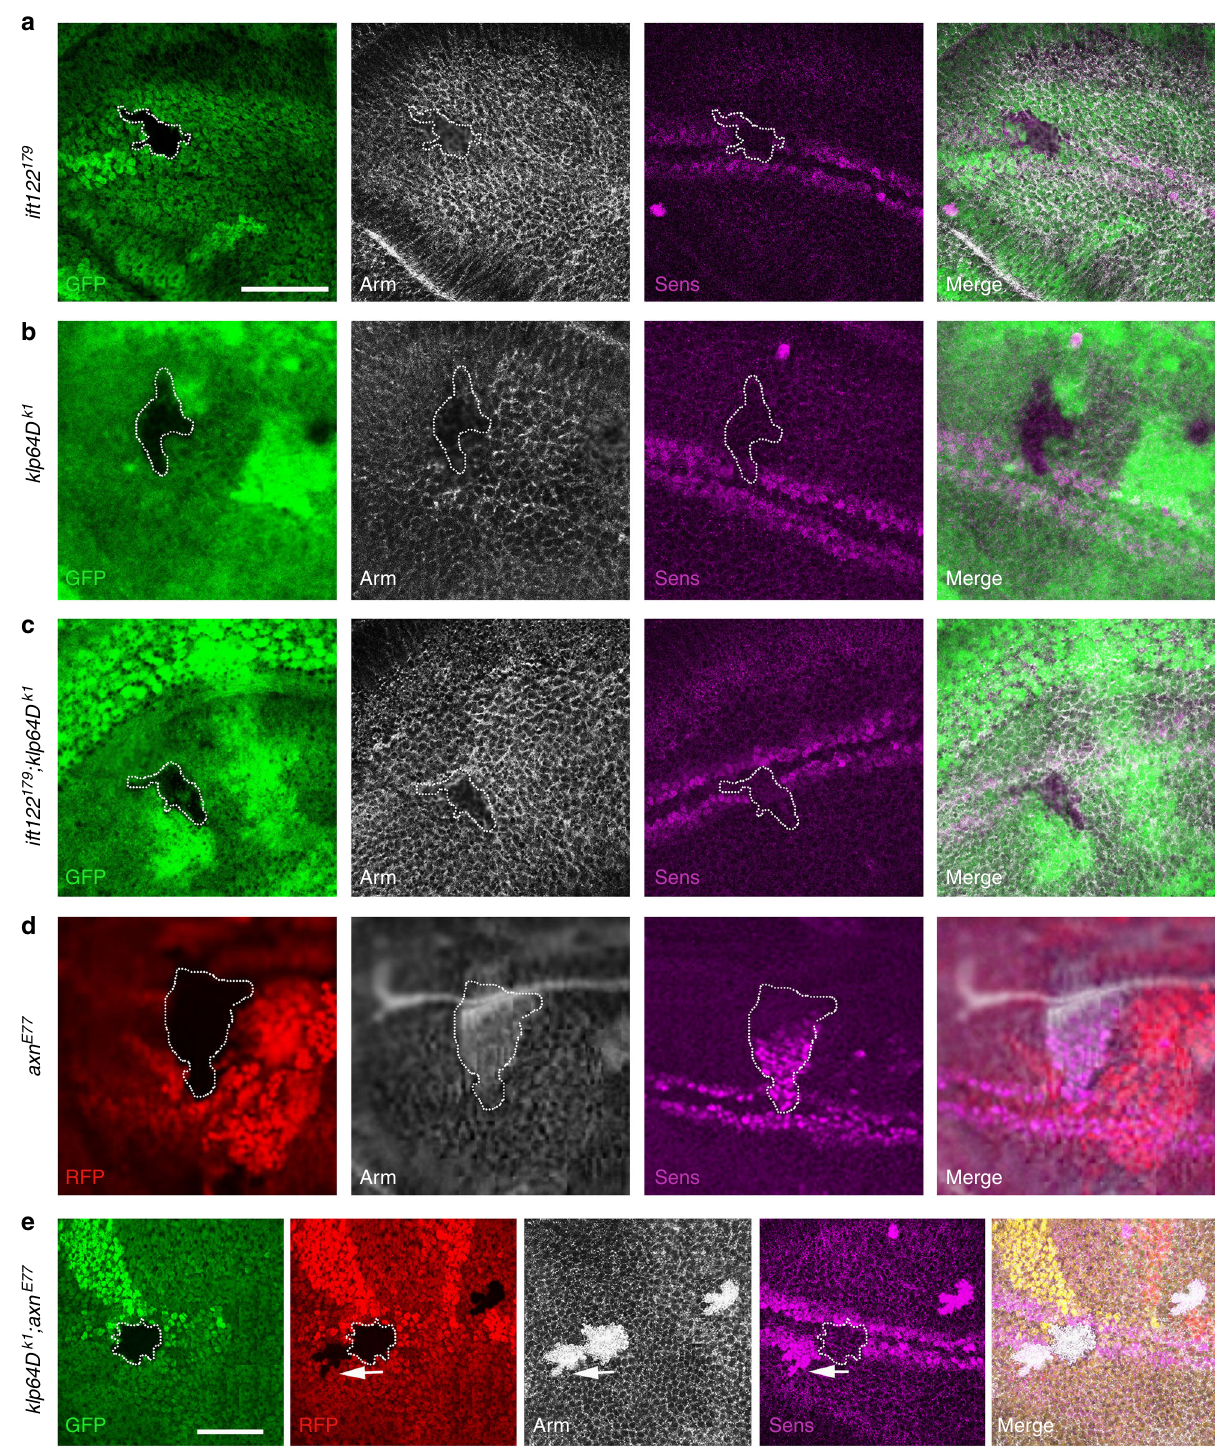
Fig. 2 The kinesin-2/IFT-A complex is required for Wg target gene expression. All panels show wing discs near wing margin (evident by Sens expression, magenta), dorsal is up. Mutant clones ( n = 20 clones in ten different wing discs) are marked by absence of GFP (green), RFP (red), or both; staining is with Arm (white), and Sens (magenta) as indicated. Genotypes of clones are as labeled on left. a Expression of Wg signaling target Sens is reduced or lost in IFT122 mutant cells. Cytoplasmic Arm levels are reduced in IFT122 mutant cells, and IFT122 mutant cells display loss or reduction of Sens. b Wg target Sens is reduced in klp64D mutant cells. Cytoplasmic Arm levels are reduced in klp64D mutant cells, and Sens expression is lost. c Expression of Sens is lost in ift122 , klp64D double mutant clones. Cytoplasmic Arm levels are markedly reduced in double mutant cells, and mutant cells display loss of Sens. d Ectopic expression of Wg target Sens in axin mutant clones. Cytoplasmic Arm levels are increased in axin mutant cells, and mutant cells display ectopic Sens expression away from margin. e klp64D , axn double mutant clones ( klp64D marked by absence of GFP and axn RFP, double mutant clones lack both markers, outlined with white line). Cytoplasmic Arm levels are increased in both single and double mutant clones, but double mutant cells display loss of Sens expression (note example of axn single mutant clone lacking only RFP, marked by arrow). Scale bars represent 50 and 30 µ